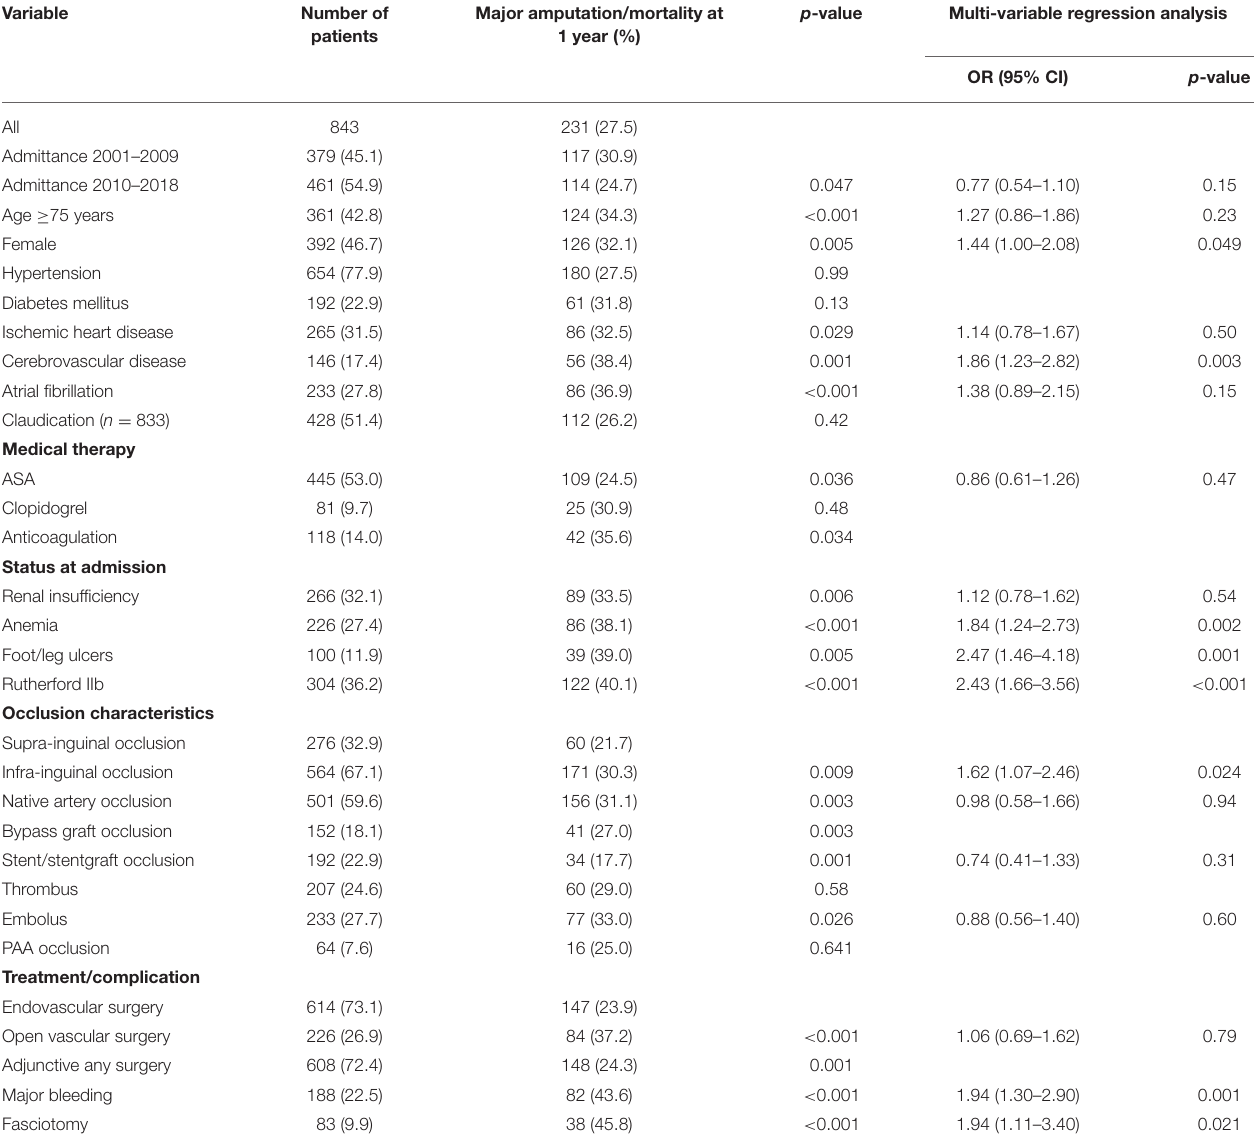
TABLE 6 | Factors associated with combined major amputation/mortality at 1-year follow up in patients undergoing open or endovascular revascularization for